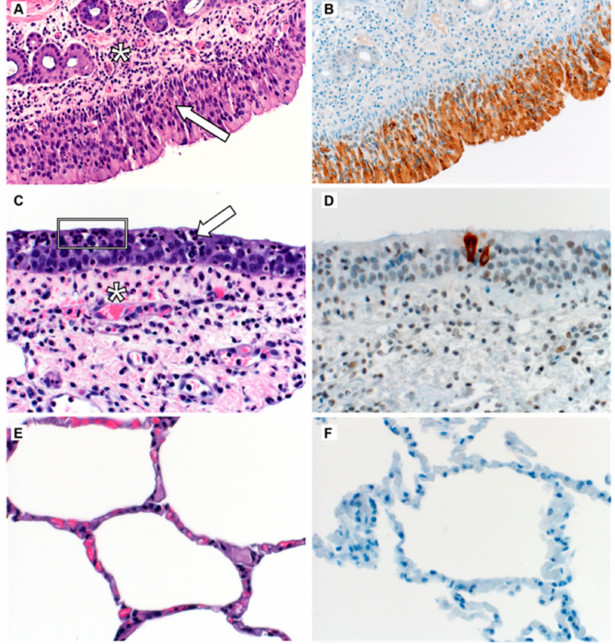
Figure 1. Histopathology and Immunohistochemistry of a Bactrian Camel Experimentally Inoculated with Middle East Respiratory Syndrome Coronavirus (MERS-CoV). ( A ) Within the nasal turbinates, the lamina propria (asterisk) and mucosa (arrow) are infiltrated by moderate numbers of neutrophils with fewer lymphocytes and macrophages. ( B ) The neurosensory ciliated epithelium of the nasal turbinates show strong immunoreactivity to MERS-CoV antigen. ( C ) Within the trachea, there is loss of cilia (ciliocytophthoria, white box) and infiltration of the mucosa (arrow) and lamina propria (asterisk) by moderate numbers of neutrophils. ( D ) There is limited immunoreactivity of ciliated epithelial cells to MERS-CoV antigen. ( E ) No histopathologic lesions are noted in the lower respiratory tract. ( F ) Immunoreactivity to MERS-CoV antigen is not detected in the lung. Magnification: 400 ×